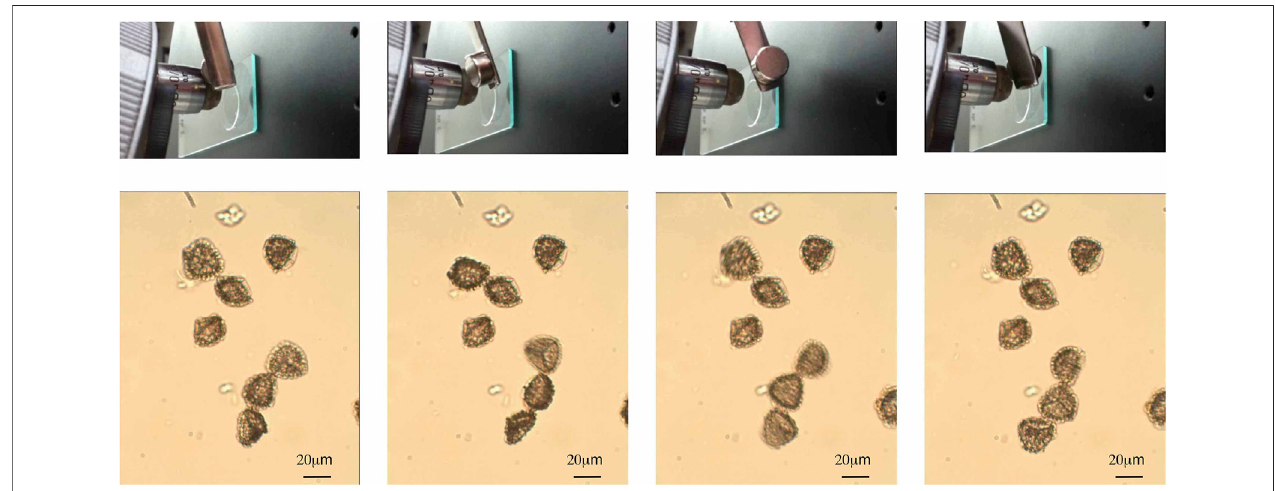
FIGURE 9 | Photomicrographs of magnetic capsules induced to rotate in water via an external magnetic fi eld. The observations were made at room temperature using a polarizing microscope in transmission (x200).